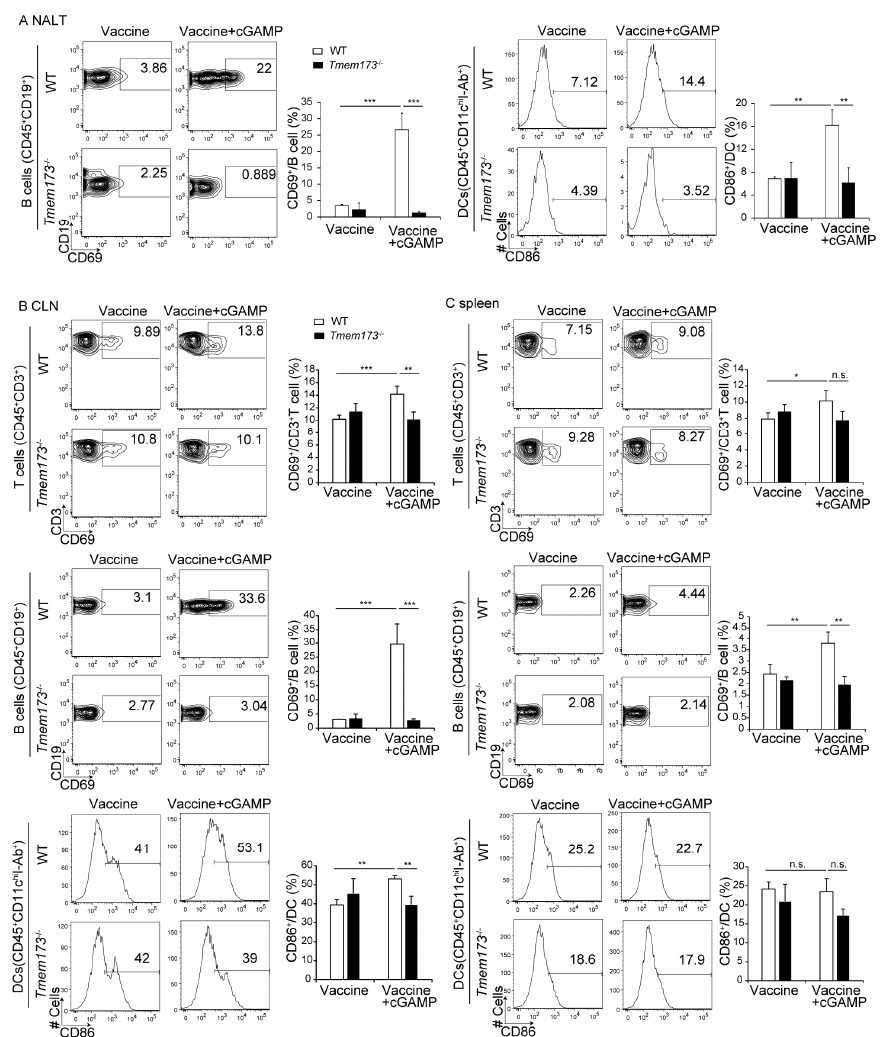
Figure 5. cGAMP activates immune cells in NALT. Cells were isolated from NALT, cervical lymph nodes (CLN), and spleens, which were harvested from WT mice vaccinated with the vaccine alone or the vaccine + cGAMP for 24 hrs. ( A ) (Left panel) NALT cells were stained with 7AAD, PE-labeled anti-CD69, Alexa Fluor 700-labeled anti-CD19, and APC-Cy7-labeled anti-CD45 Abs for B-cells. Cells gated with 7 aminoactinomycin D (AAD) − CD45 + CD19 + cells are shown as B-cells. (Right panel) NALT cells were stained with 7AAD, FITC-labeled anti-CD86, PE-labeled anti-I-Ab, PECy7-lebeled anti-CD11c Abs, and APCCy7-labeled anti-CD45 Abs for dendritic cells (DCs). Cells gated with 7AAD − CD45 + CD11c hi I-Ab + cells are shown as DCs. ( B , C ) Flow cytometry analysis of cells prepared from CLNs ( B ) and spleens ( C ), stained with Abs by the same protocol as shown in ( A ). Cells stained with 7AAD, FITC-labeled anti-CD69, PECy7-labeled anti-CD3, and APCCy7-labled anti-CD45 Abs. Cells gated with 7AAD − CD45 + CD3 + are shown as T-cells. One representative experiment out of three is shown. The indicated numbers show the percentages of gated populations. The values are presented as the mean ± SD of 3 mice for each group. * p < 0.05; ** p < 0.01; *** p < 0.001 and n.s.: not significant in the Mann-Whitney U test.